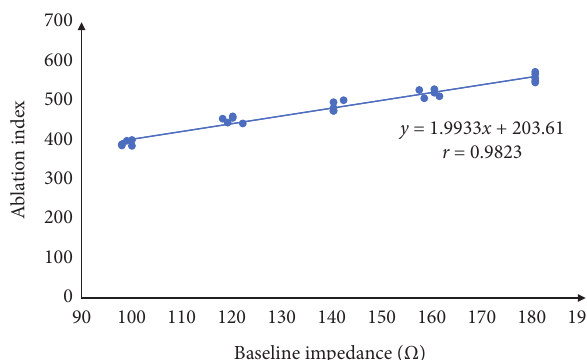
Figure 3: The relationship between the AI and the baseline impedance in the similar ablation depths.